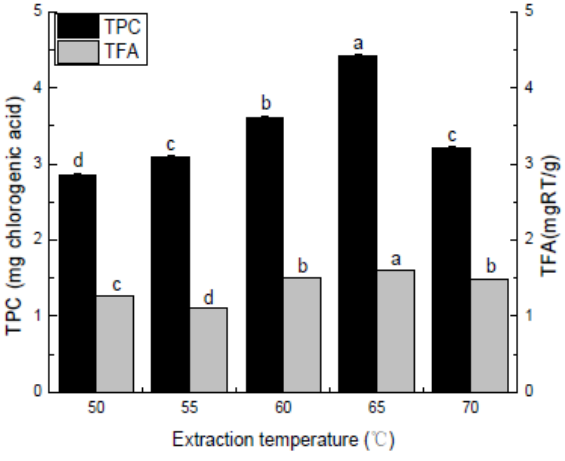
Figure 3. Extraction temperature (°C). Three independent experiments were carried out for each analysis. Result is expressed as a mean ± SD ( n = 3). Values with the different letters in the column are significantly different by Duncan’s multiple range test ( p < 0.05).